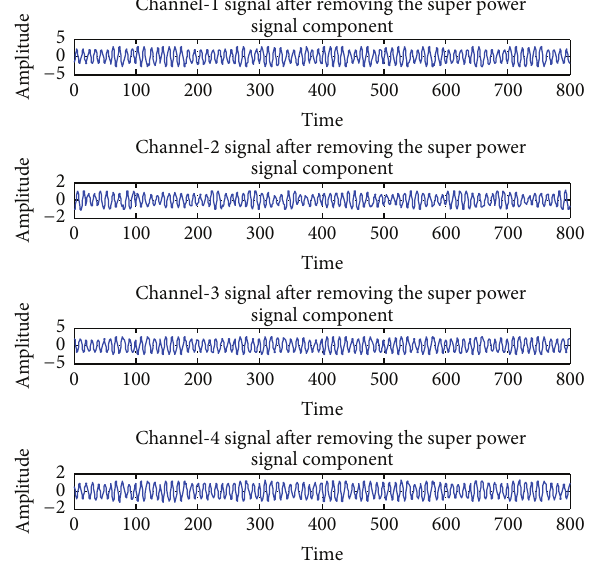
Figure10:Thefourextractedweakobjectsignalwaveformswiththe proposed Interference Cancellation algorithm